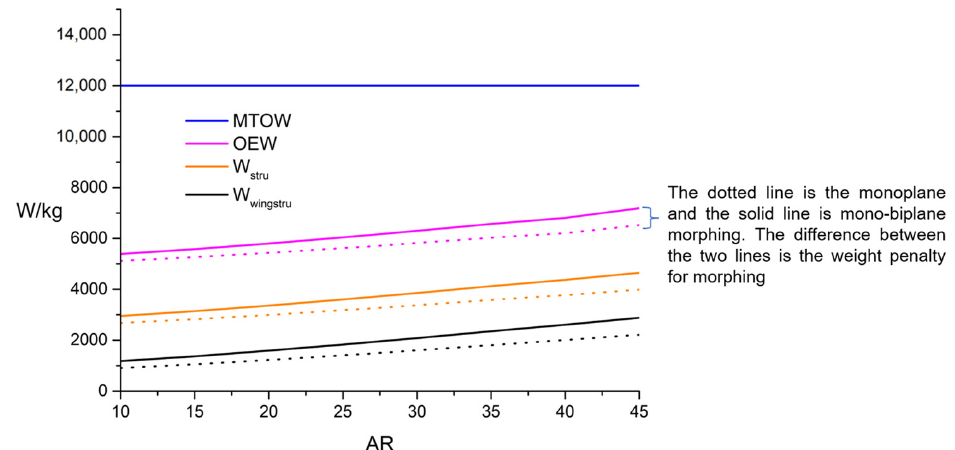
Figure 11. Weight composition of the two aircraft at different cruise aspect ratios.